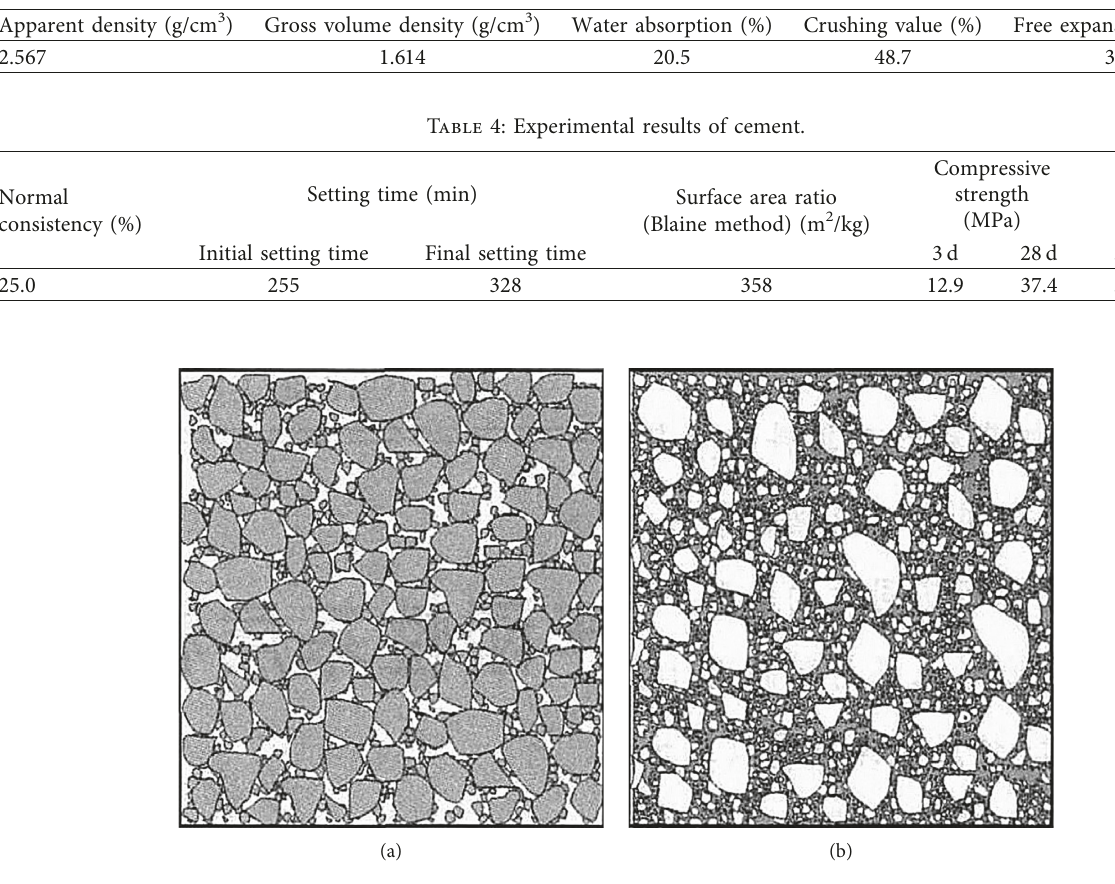
Table 3: The physical properties of oil shale semicoke.